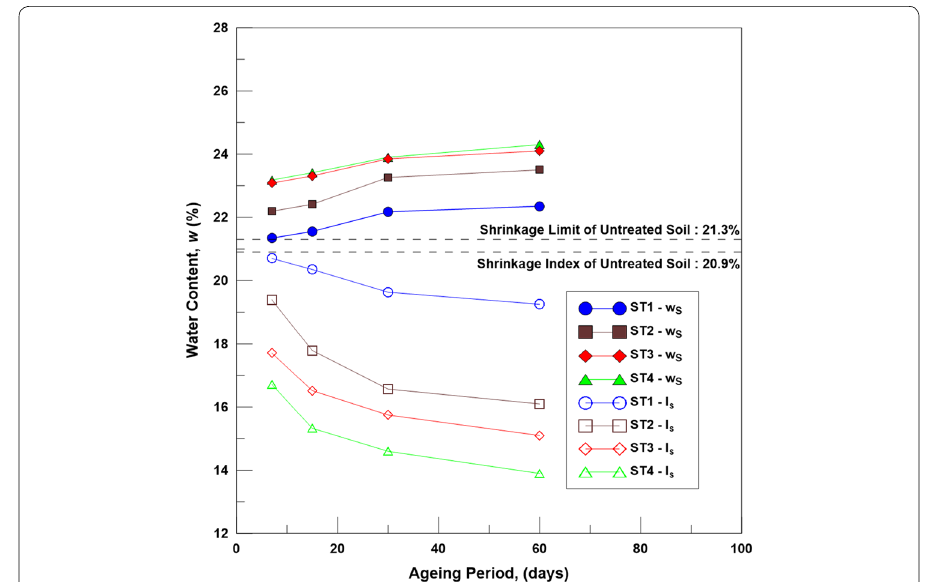
Fig. 4 Effect of enzymes on Shrinkage